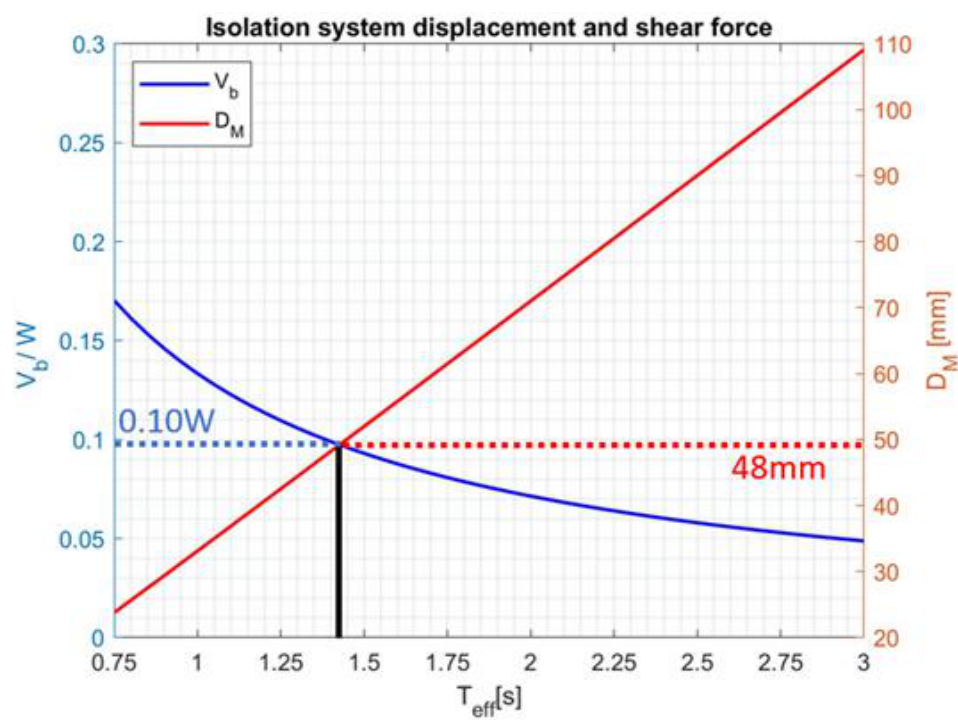
Figure 3. FEMA P-751 equivalent lateral force procedure results.